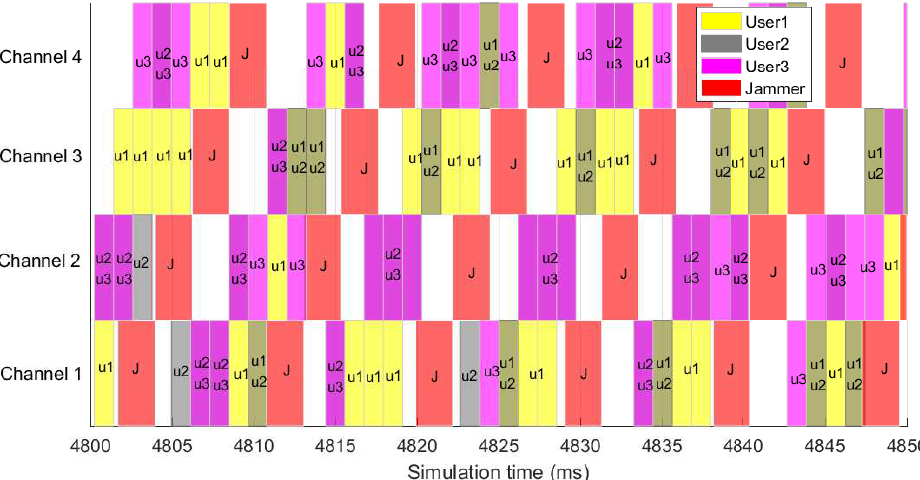
Figure 7. The time-frequency diagram after LCADCSA converging in the first